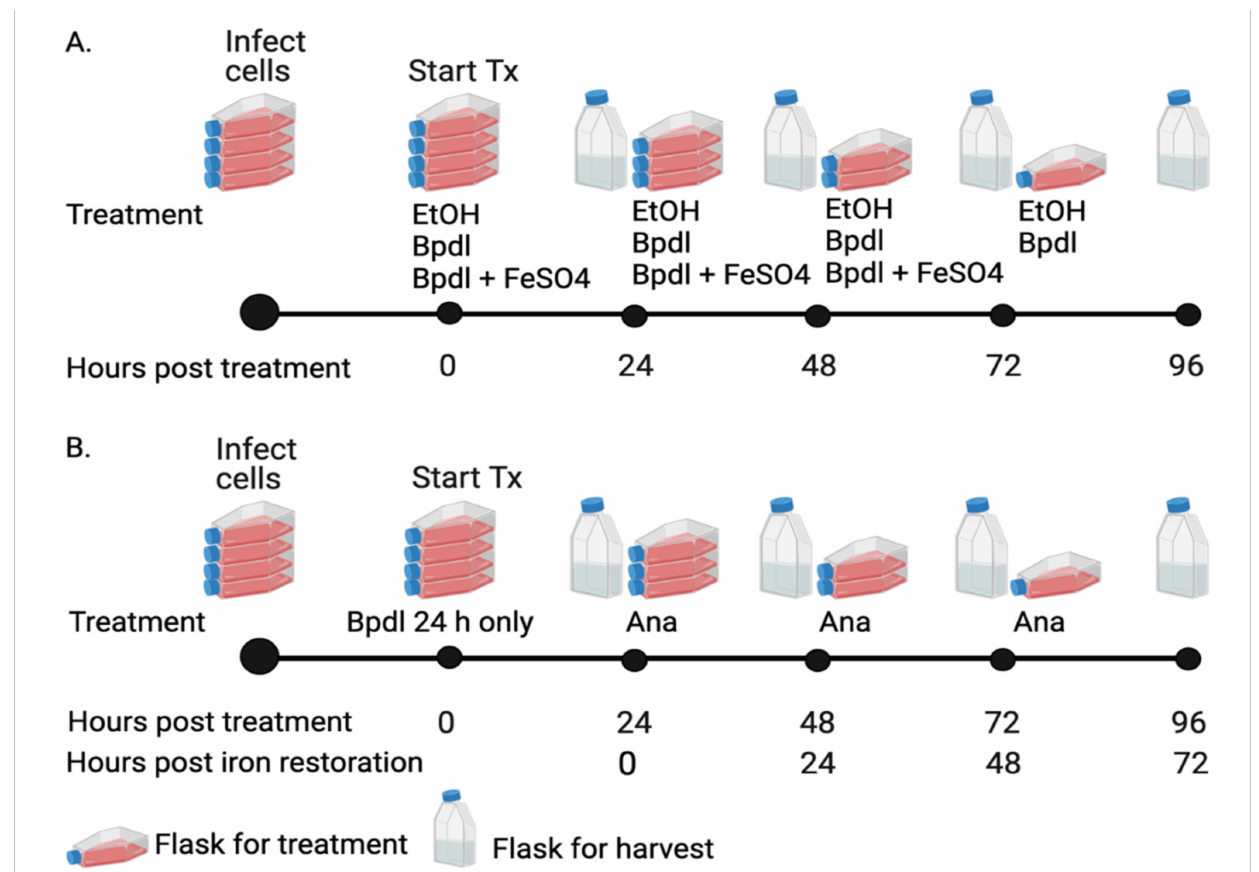
Figure 2. Experimental design. Timeline for A. marginale infection, treatments, and cell harvests for ( A ) iron depletion using Bpdl and recovery with FeSO 4 in DAE100 cells and ( B ) reversal of iron depletion using iron replete, Anaplasma (Ana) medium. For all experiments, cells were infected with A. marginale 24 h prior to the initiation of treatments. ( A ) DAE100 cells were treated every 24 h with Bpdl, the carrier ethanol (EtOH), or Bpdl plus various concentrations of FeSO 4 . Cells were harvested starting 24 h following the first treatment and each 24 h thereafter. Cells treated with Bpdl or the carrier were harvested up to 96 h post-treatment, while cells treated with Bpdl plus FeSO 4 , were harvest up to 72 h post-treatment. ( B ) To reverse iron depletion, A. marginale -infected DAE100 cells were treated with Bpdl for 24 h only. Cells received Anaplasma medium for the remainder of the experiment. Cells were harvested starting 24 h following the first treatment and each 24 h thereafter up to 96 h post-treatment, which corresponded to 72 h after iron